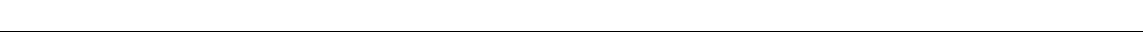
Fig. 4 A protein translation activity associated with invadosome rosettes. a Lifeact-mRuby (red)-expressing NIH-3T3-Src cells were stained with an ER- tracker (green). Representative confocal images are shown. On the left panel, a Z -stack reconstruction shows an invagination of the ER into a invadosome rosette. A magni fi cation of a rosette shows the ER organization into this structure. Scale bars: 10 µ m (right panel) and 2 µ m (left panel). b Upper panel: correlative light and electron microscopy (CLEM) in vitro. First, a confocal acquisition of a lifeact-mRuby (red)-expressing NIH-3T3-Src cell forming rosettes (arrow heads) is taken. Then, the exact same cell is imaged by transmitted electron microscopy (TEM). Next, the position of rosettes is correlated between confocal and electron microscopy (arrowheads). The dashed square represents the area imaged in the panel below. Scale bar: 5 µ m. b Lower panel: TEM micrographs of the rosette outlined in the upper panel (box, yellow arrow head). The boxed region is displayed at a higher magni fi cation in the bottom images. The area containing ribosomes is highlighted in blue. Single or small groups of ribosomes are represented by individual blue dots. Outline of the rosettes is marked in yellow. The images on the right are a 3D reconstruction of the rosette with ribosomes located at the periphery of the full rosette. The 3D model is 1.54 µ m thick and composed of 22 sections. Scale bars: fi rst line 1 µ m, second line 100 nm; 3D reconstruction: 1 µ m. c Confocal images of a smiFISH experiment using a speci fi c probe set against β -actin mRNA (green) in NIH-3T3 WT and NIH-3T3-Src cells. β -Actin protein was immnunolabeled in red. Panels on the right show enlarged views of the boxed regions. Scale bars: 10 µ m. d NIH-3T3-Src cells were treated or not with 40 nM anisomycin for 30 min. Cells were then stained for puromycin (green) to label translating ribosomes and F-actin in red. Panels on the right show enlarged views of the boxed regions. Scale bars: 10 µ